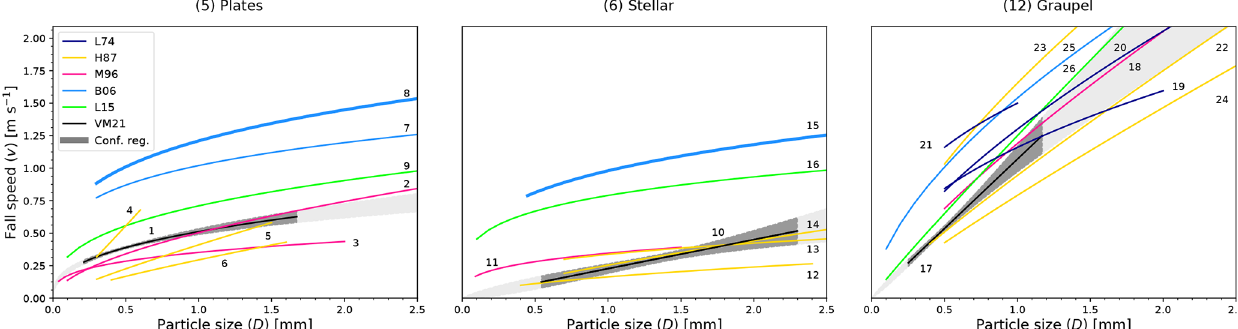
Figure 13. A comparison of the fall speed vs. particle size ( v vs. D ) relationships between this study and previous studies for some shape groups: (5) Plates , (6) Stellar , and (12) Graupel . For the comparison, v vs. D parameterizations from Locatelli and Hobbs (1974) L74, Heymsfield and Kajikawa (1987) H87, Mitchell (1996) M96, Barthazy and Schefold (2006) B06, Lee et al. (2015) L15, and this work VM21 are shown. These v vs. D relationships are the same as those shown and enumerated in Table 6. The thickness in the lines corresponding to B06 represents the riming degree: the thinner line denotes “unrimed”, and the thicker one denotes “moderately rimed”. The power laws that correspond to VM21 are shown together with their respective 68% confidence regions ( M b ). The lengths of all relationships correspond to the ranges of D (see Table